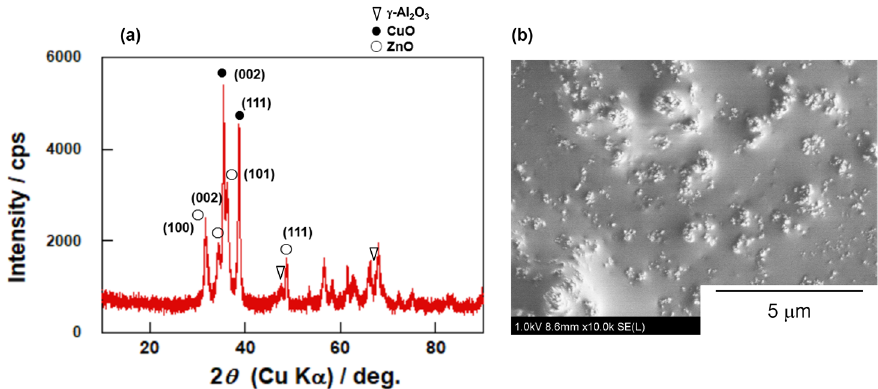
Figure 3. ( a ) XRD patterns and ( b ) typical FE-SEM images of CuO/ZnO/ γ -Al 2 O 3 catalyst.